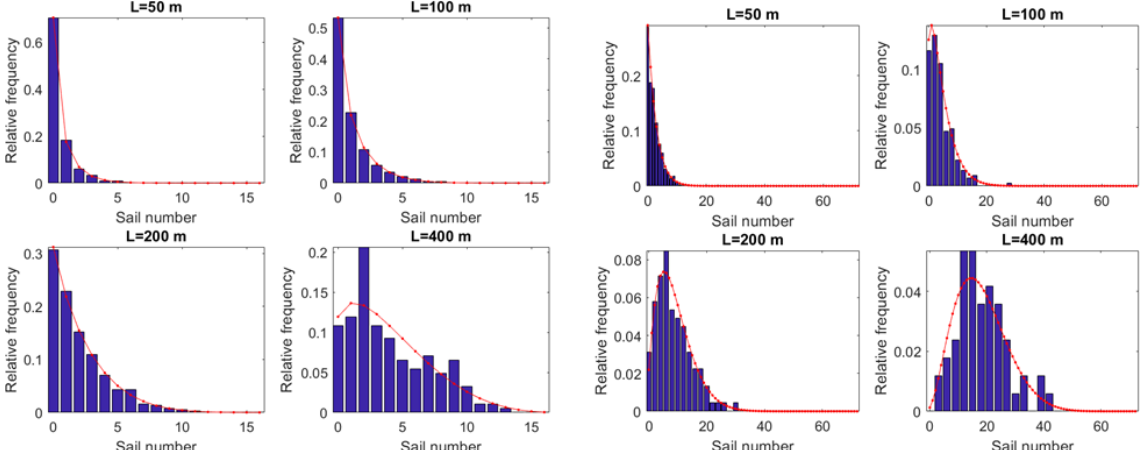
Figure 4. Hypergeometric fits for distributions k(n j | n i ) conditioned by L i = 1600m and n i = 16 (left panel group) and n i = 72 (right panel group). The scales L j belong to [ 50 , 100 , 200 , 400 ] .